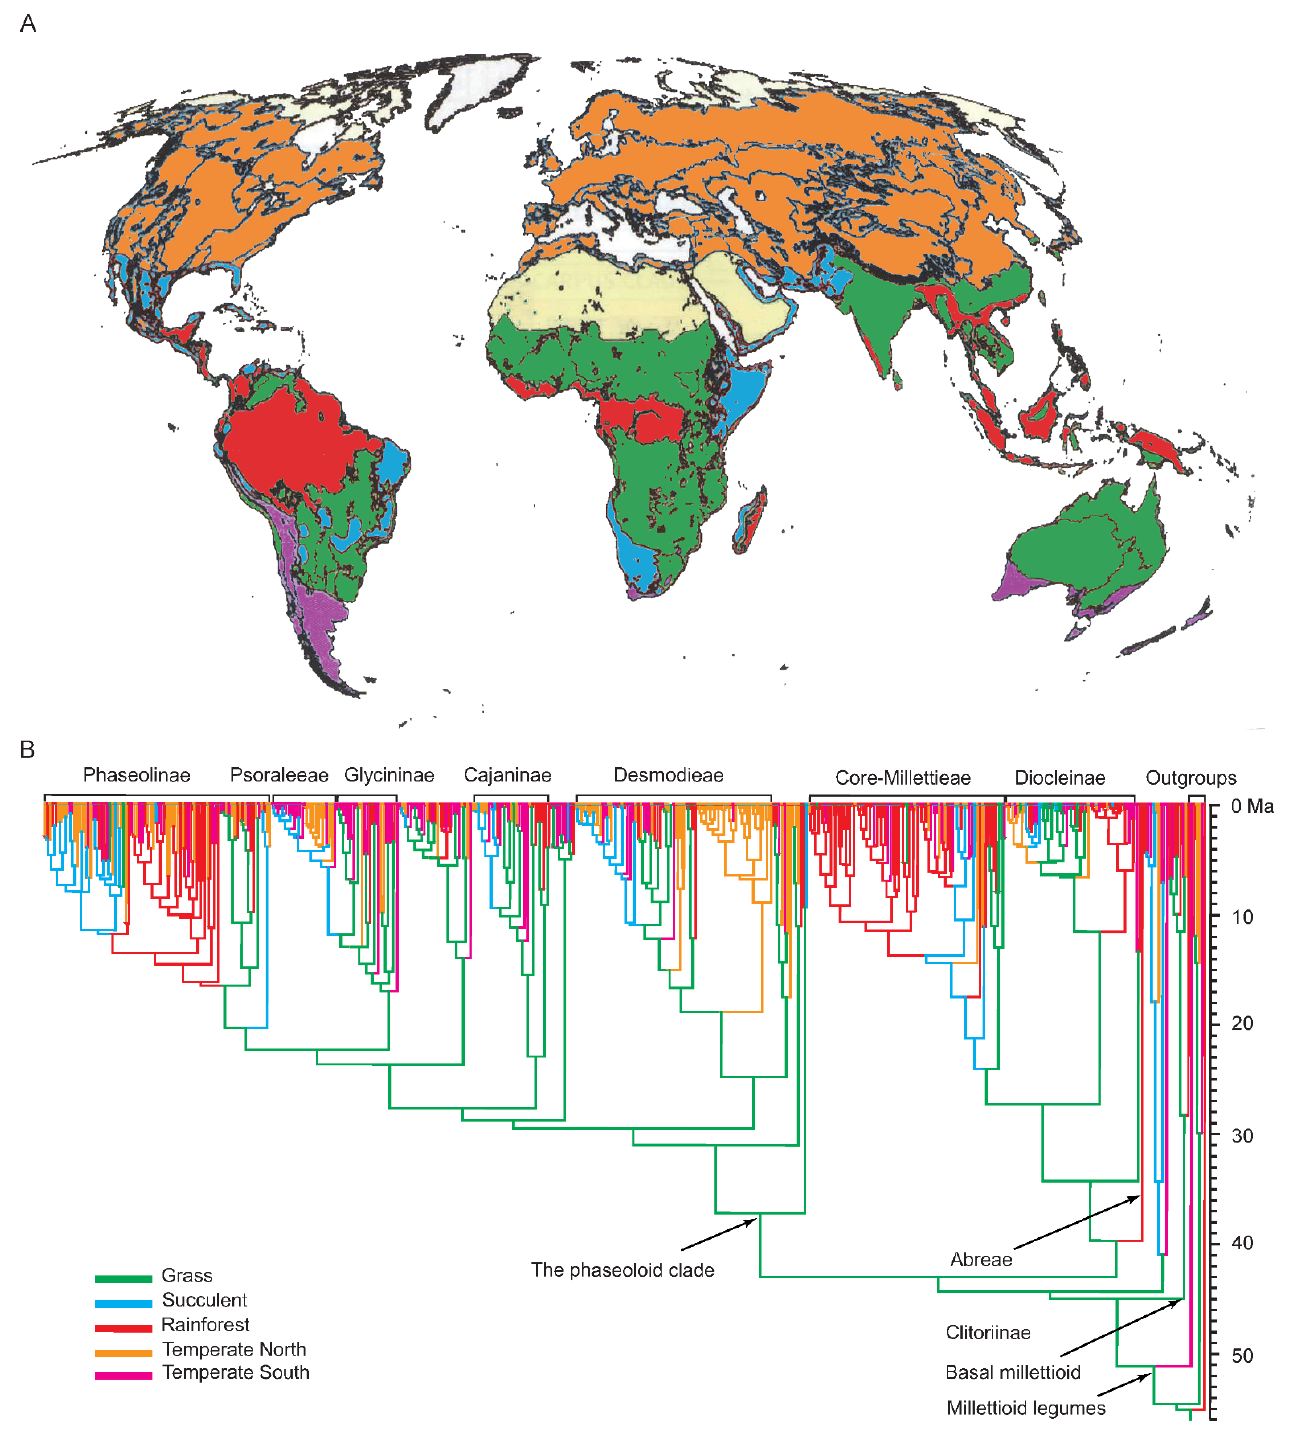
Figure 3. Biome evolutionary history of the Millettiod legumes. ( A ) World map of biome (edited from Lewis et al., 2005 [9]). ( B ) Ancestral biome state reconstruction of the Millettiod legumes using parsimony method.